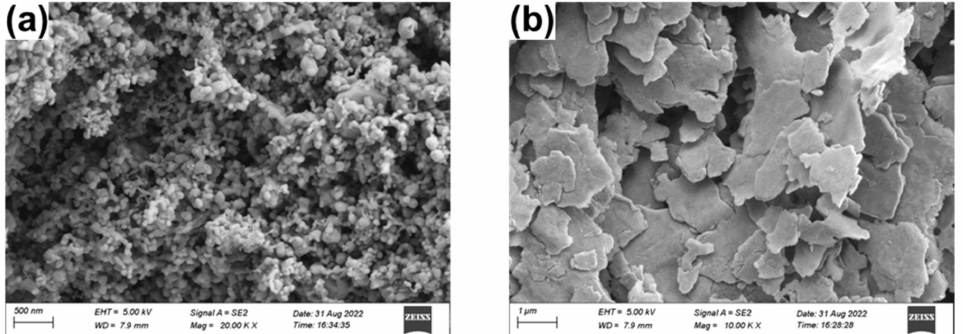
Figure 1. SEM photographs of nano silver powder ( a ) and flake silver powder ( b